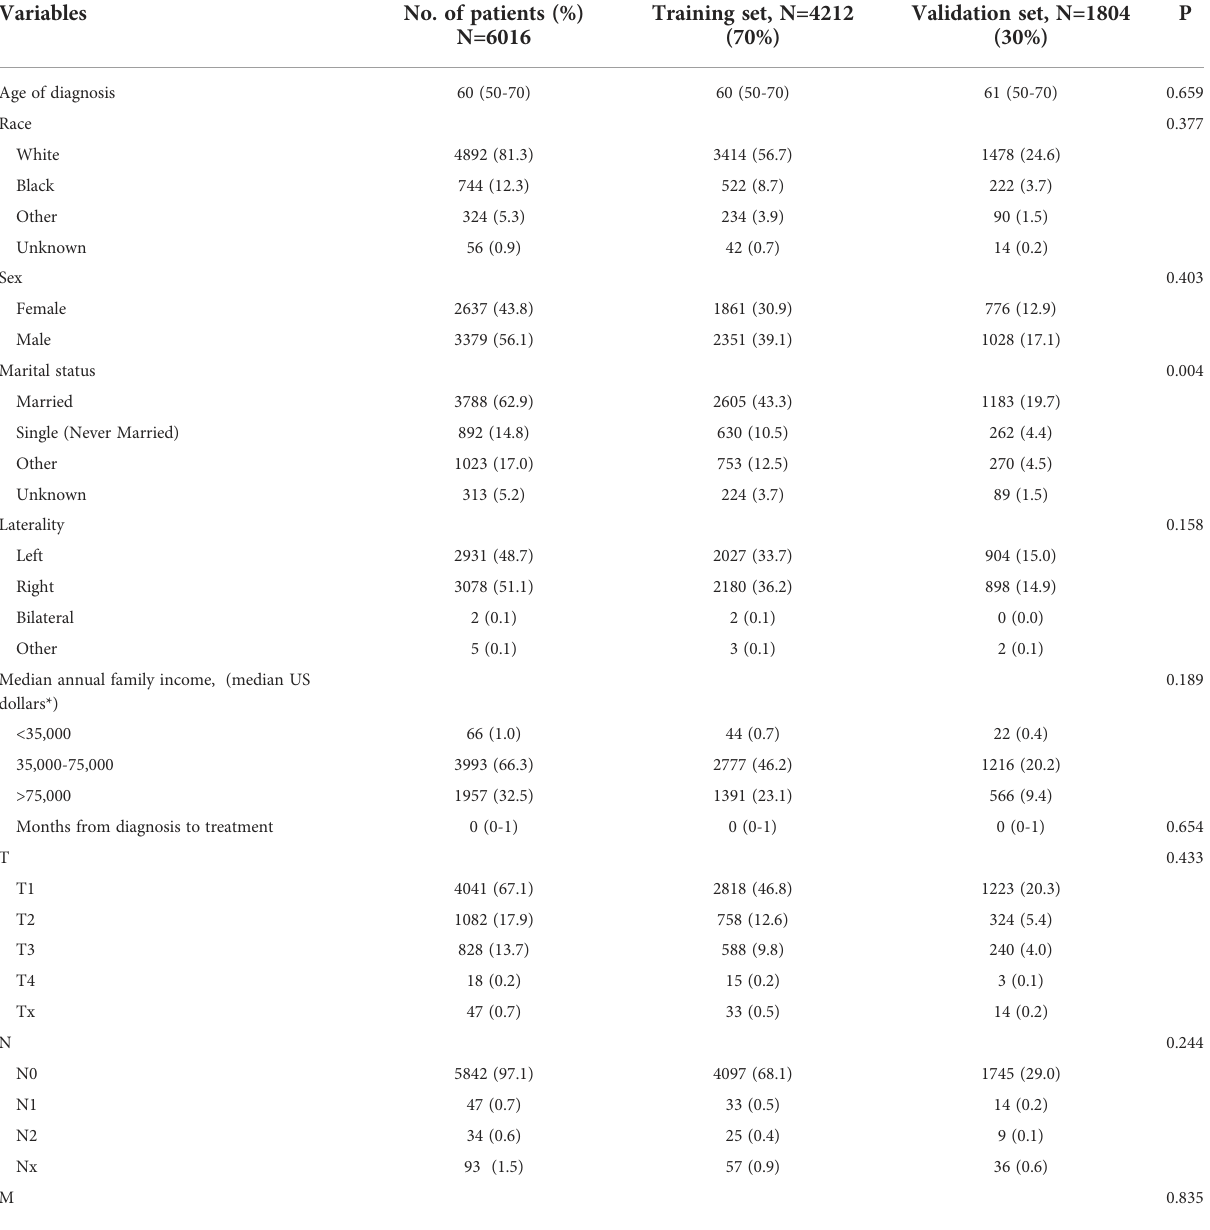
TABLE 2 Patients ’ demographics and clinicopathological